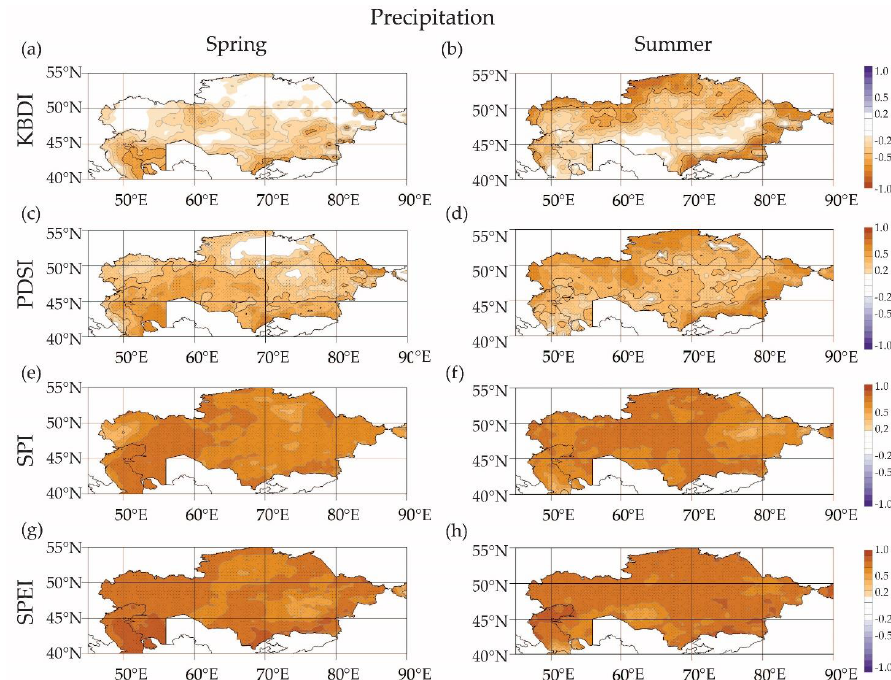
Figure 9. The spatial distribution of correlation coefficients between precipitation and dryness indices in spring (left column) and summer (right column). The areas with statistically significant correlation coefficients ( p < 0.05) are shaded. The color scale for KBDI is inverted as an increase in KBDI corresponds to the growth of aridity, while for other indices, the higher values coincide with wetter conditions. ( a , b ) KBDI ,( c , d ) PDSI, ( e , f ) SPI, ( g , h ) SPEI.